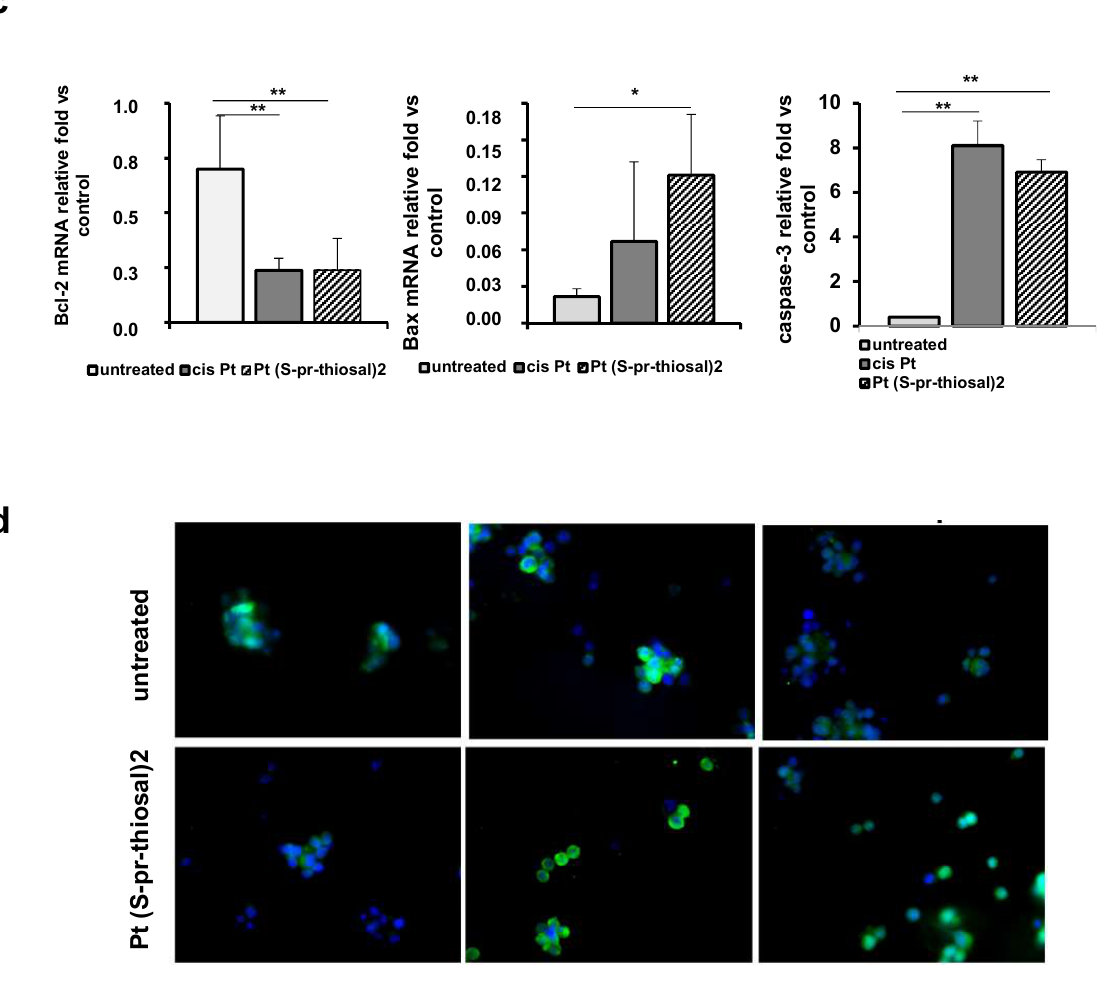
Figure 2. Pt( S -pr-thiosal)2 enhances expression of proapoptotic molecules, while reducing expression of antiapoptotic molecules in BCL1 cells. ( a ) The graphs show the mean for the percentage of Noxa and Bcl2 positive BCL1 cells. The statistical significance of the difference in the percentage of apoptotic cells was determined by Student’s t test; * p < 0.05, ** p < 0.01 and indicates the difference in the percentage of BCL1 cells treated with platinum complex at 0.05 mg/mL and all three other groups of BCL1 cells (untreated; treated with cisplatin; and treated with platinum complex at 0.01 mg/mL). ( b ) Representative histograms show the expression of Bcl-2 and Noxa in untreated, cisplatin-treated, and Pt( S -pr-thiosal)2 treated BCL1 cells; ( c ) Mean values +SD for expression of mRNA for Bcl2, Bax and caspase-3 detected in BCL1 cells by real-time qRT-PCR for 5 samples per group are shown. The statistical significance was determined by Student’s t test; * p < 0.05, ** p < 0.01. ( d ) Immunofluorescence staining for (green stained proteins Bcl-2 (left), Bax (middle), and active form of caspase 3 (right); DNA stained blue) (DAPI)) in BCL1 cells untreated and treated with platinum complex for 12 h at a dose of 0.05 mg/mL, magnification 200 ×